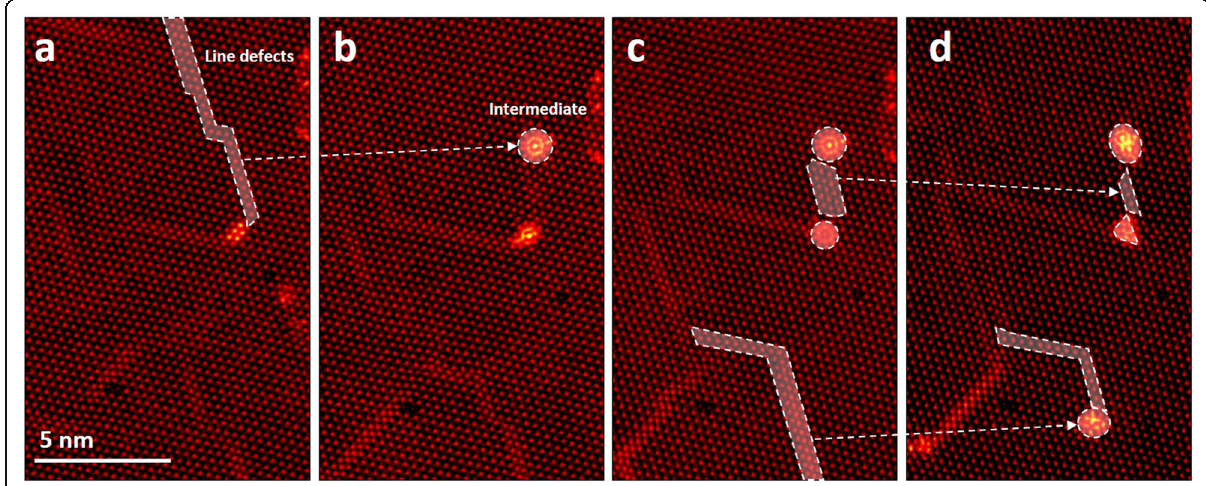
Fig. 3 Formation of the intermediate phase of the atomic cluster inside the monolayer WS 2 sheet. a ADF-STEM image showing line defects before conversion into the intermediate phase ( b ). c – d ADF-STEM images showing that line defects can be narrowing that is followed by forming the intermediate